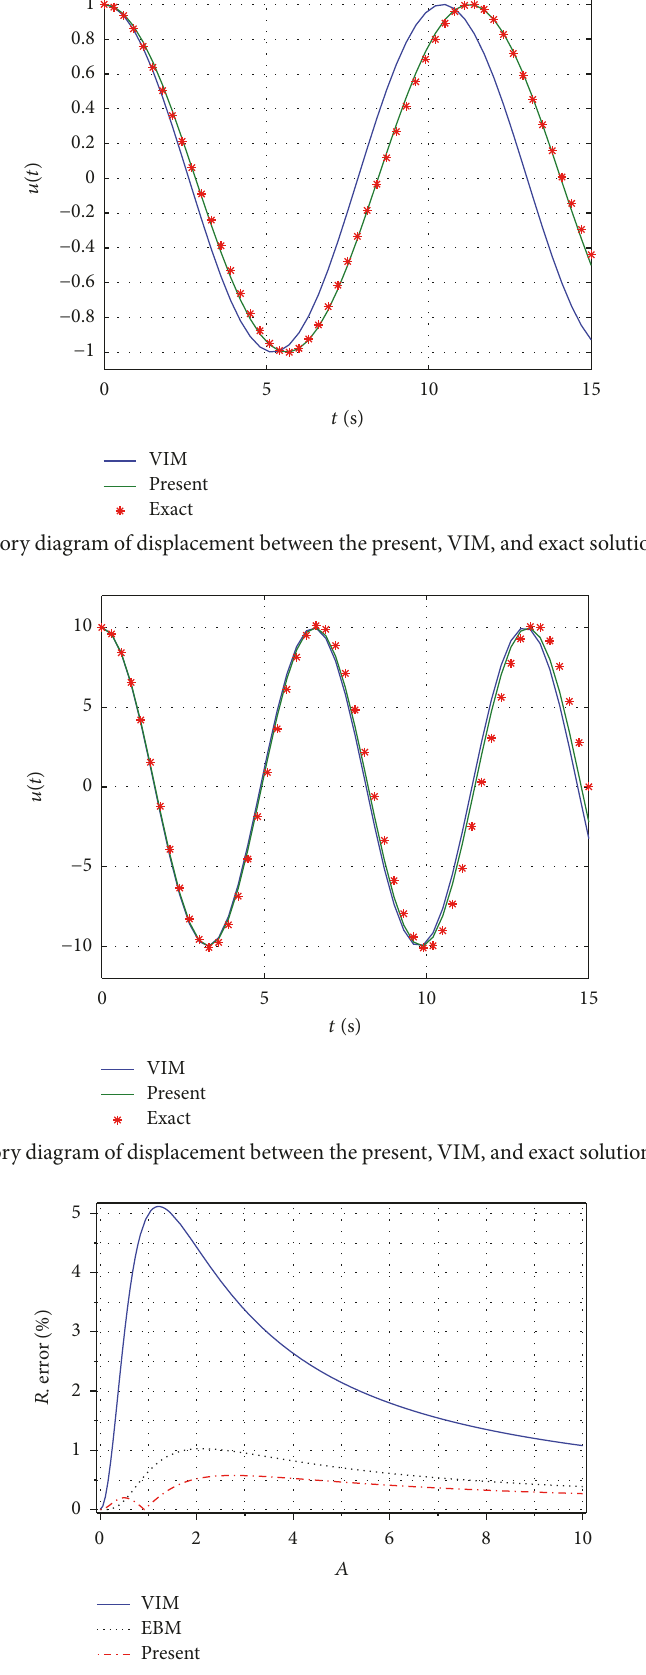
Figure 10: Comparison of relative error between the present, VIM, and EBM solutions with 𝜂 = 0.75 , Example